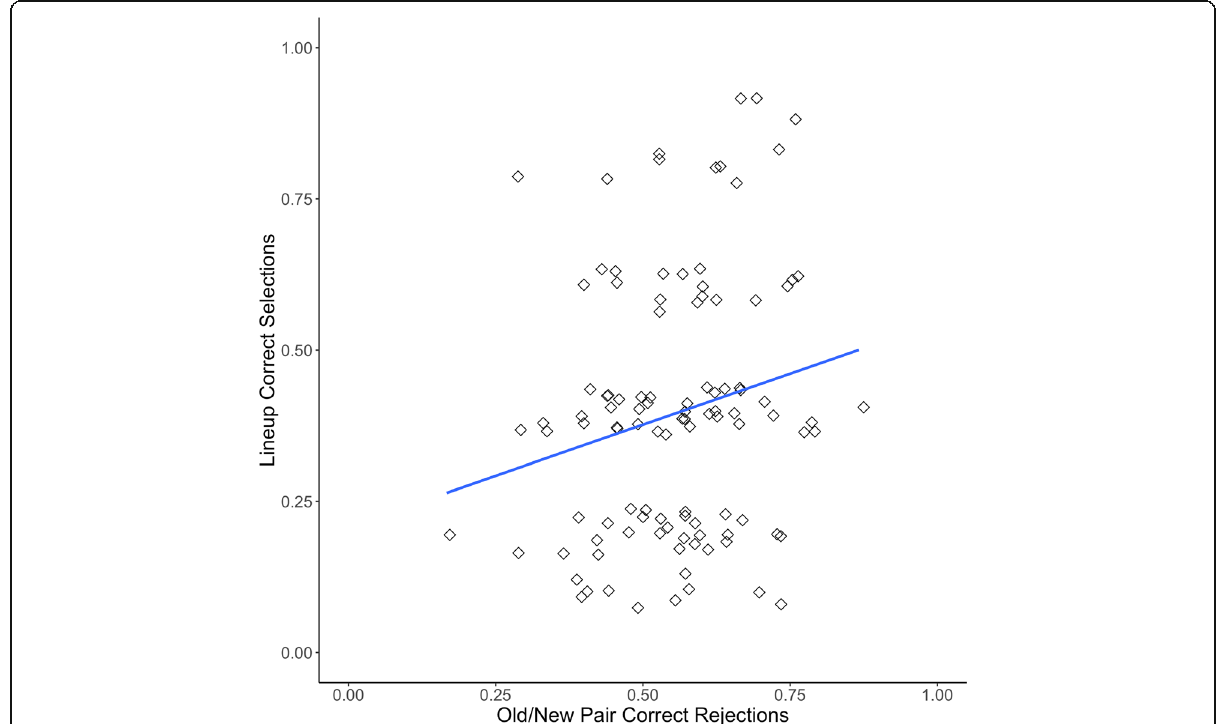
Fig. 5 Face recognition skill correlation for Experiment 2 with linear trendline, both axes